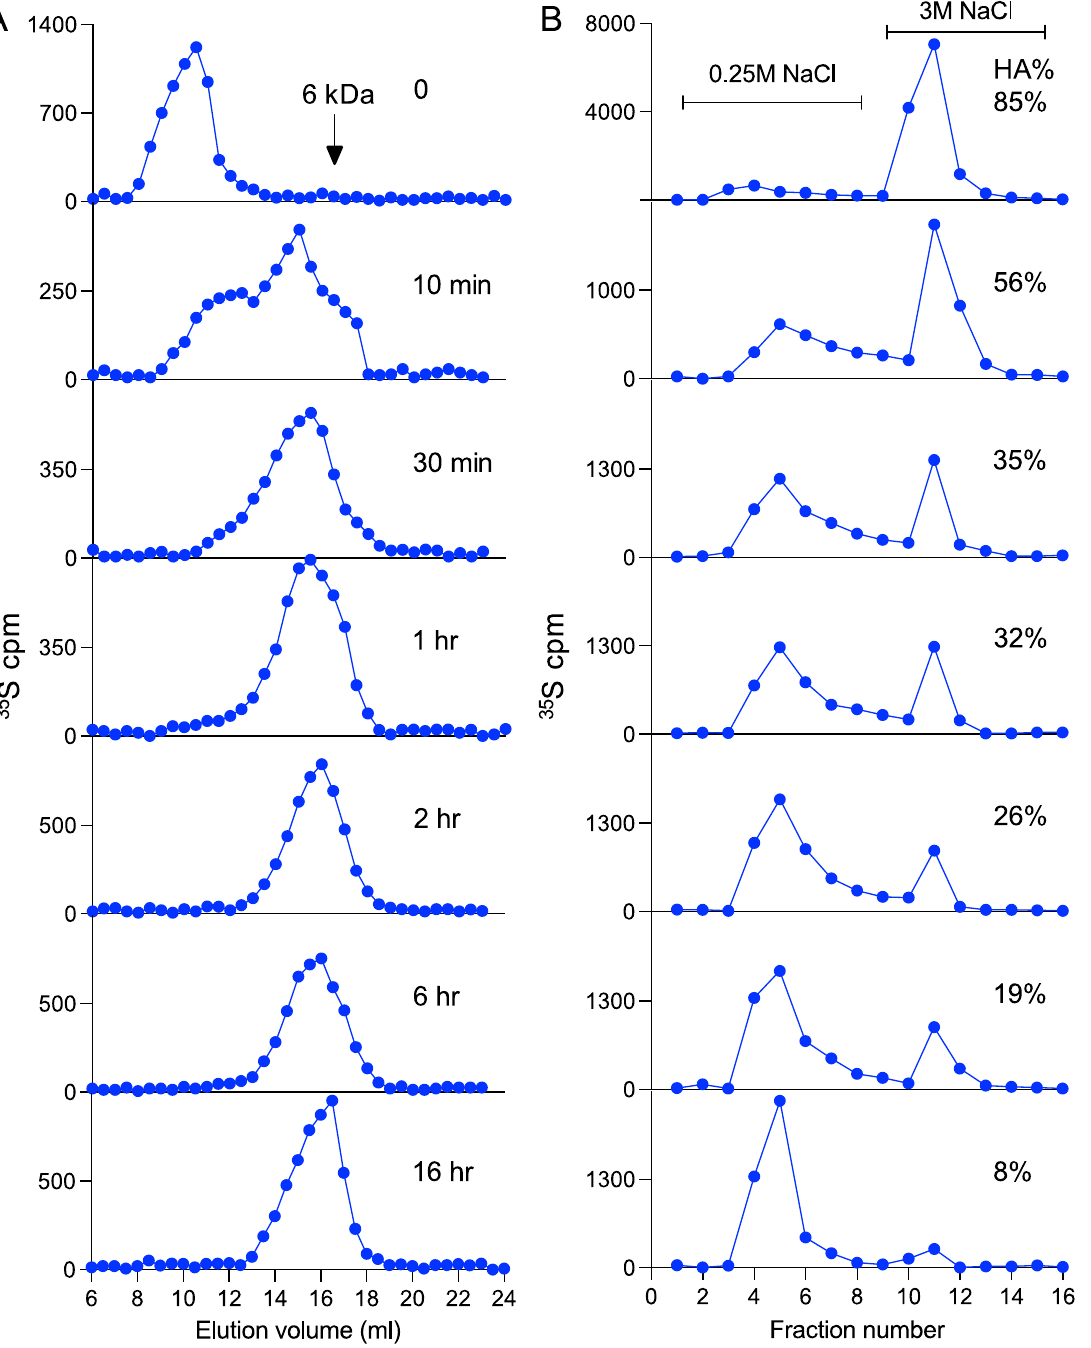
Figure 3. In vitro heparanase degradation of heparin and antithrombin binding. Metabolically 35 S- labeled WT-FSMC heparin was incubated with the same amount of purified recombinant heparanase (see Supplementary Figure S4 for heparanase preparation) for varied times as indicated in the panels of ( A ). The resultant products were divided into two fractions, one fraction was analyzed for molecular size on Superose-6 ( A ), and the other was applied to AT-Sepharose column eluted with increasing NaCl concentrations (B). The percentage of heparin bound to AT-Sepharose with high affinity (HA) is indicated in each panel of ( B ). Note that the amount of heparin applied onto the columns was different for each chromatography. The values reported in ( B ) represent the mean of analytical duplicates. The whole experiment was repeated two times with similar results.